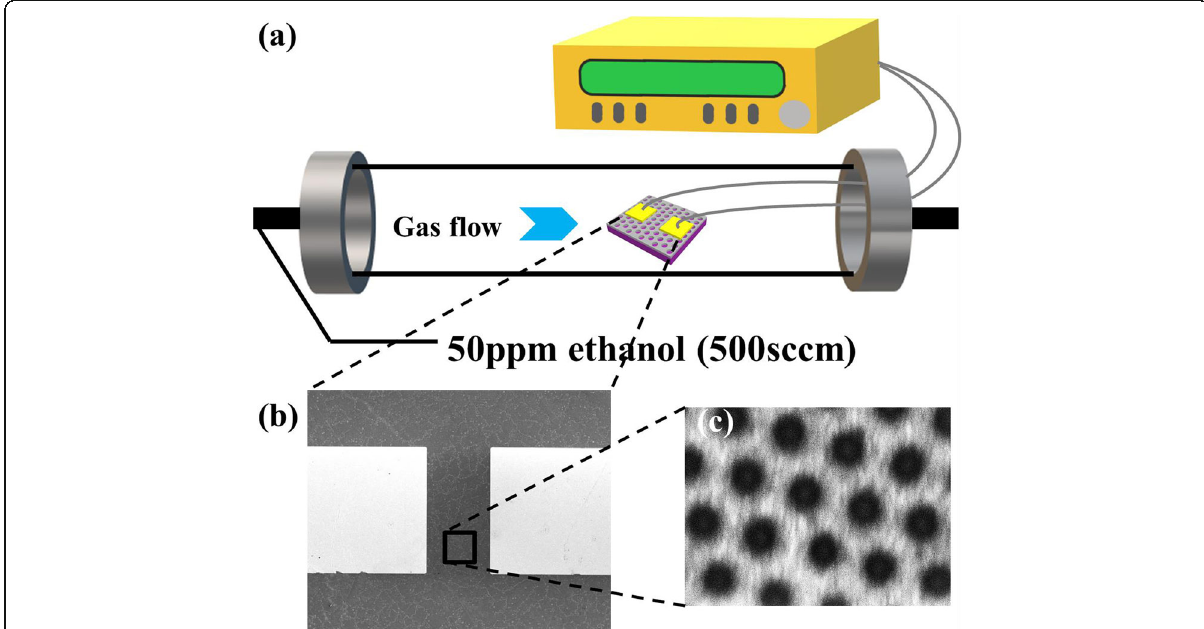
Fig. 2 a Schematic diagram of the homemade gas-sensing instrument. b SEM image of a measured device. c Magnified SEM image showing the cross-linked SnO 2 /NiO sensing